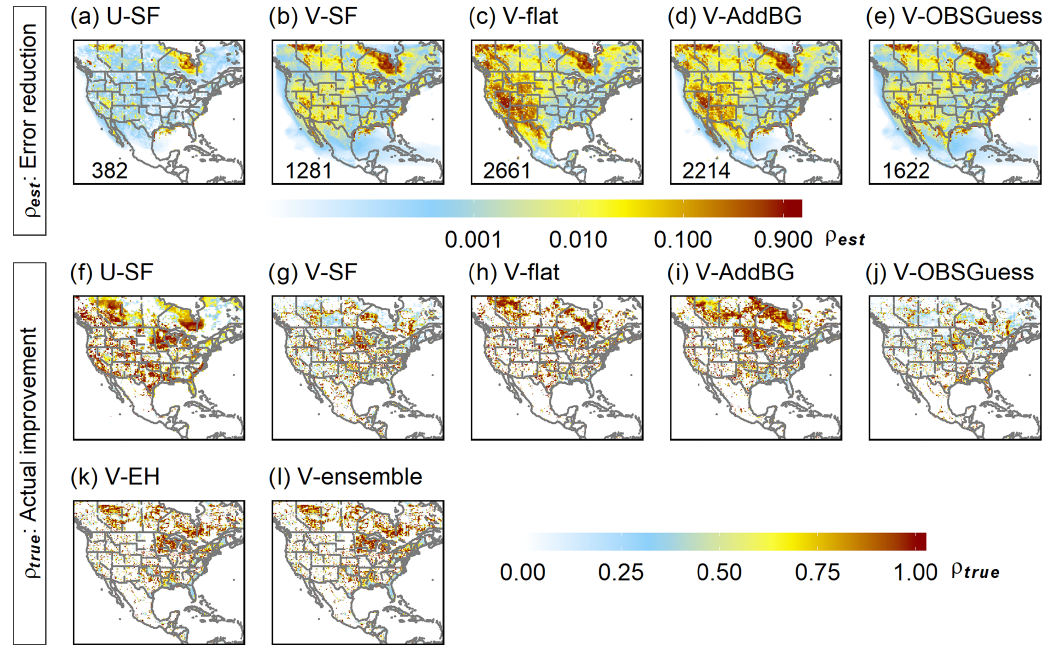
Figure 7. Posterior error reduction derived via gradient-based randomization (top row; degrees of freedom for signal are labeled inset; ρ est (i) = 1 − S opt (i,i)/ S a (i,i)) and actual grid-level emission improvement (bottom rows; ρ true (i) = 1 − (cid:0)